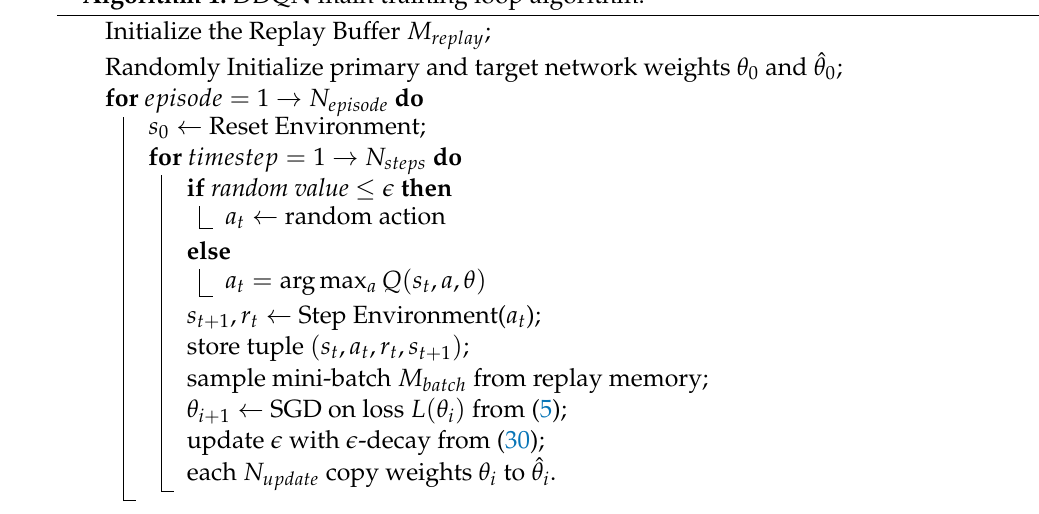
Algorithm 1: DDQN main training loop algorithm.